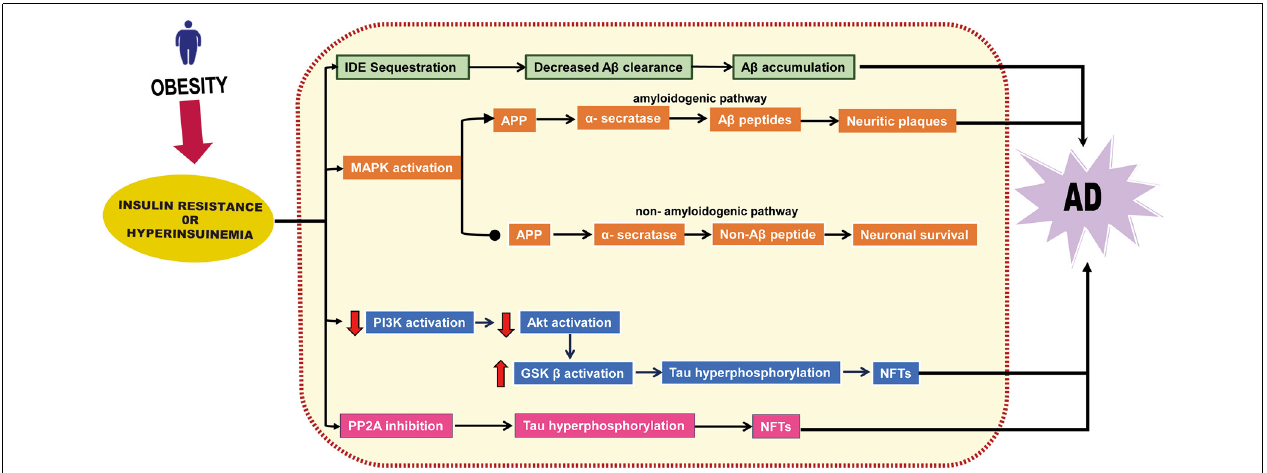
FIGURE 2 | Insulin resistance or hyperinsulinemia-related neurodegenerative pathway. Insulin resistance or hyperinsulinemia induces degradation of insulin-degrading enzyme (IDE), affects the MAPK signaling pathway, stimulates the amyloidogenic pathway, and inhibits the non-amyloidogenic pathway, thereby facilitating the accumulation of amyloid β (A β ). It also induces Akt downregulation that eventually boosts glycogen synthase kinase (GSK) β activation and inhibits phosphatase 2A (PP2A) which leads to neurofibrillary tangles (NFTs) formation.